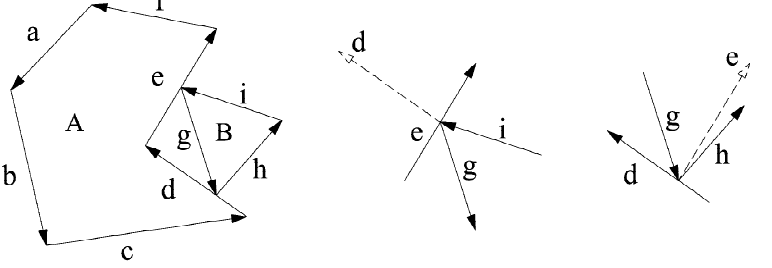
Figure 6. Method of identifying the feasible translation vector.